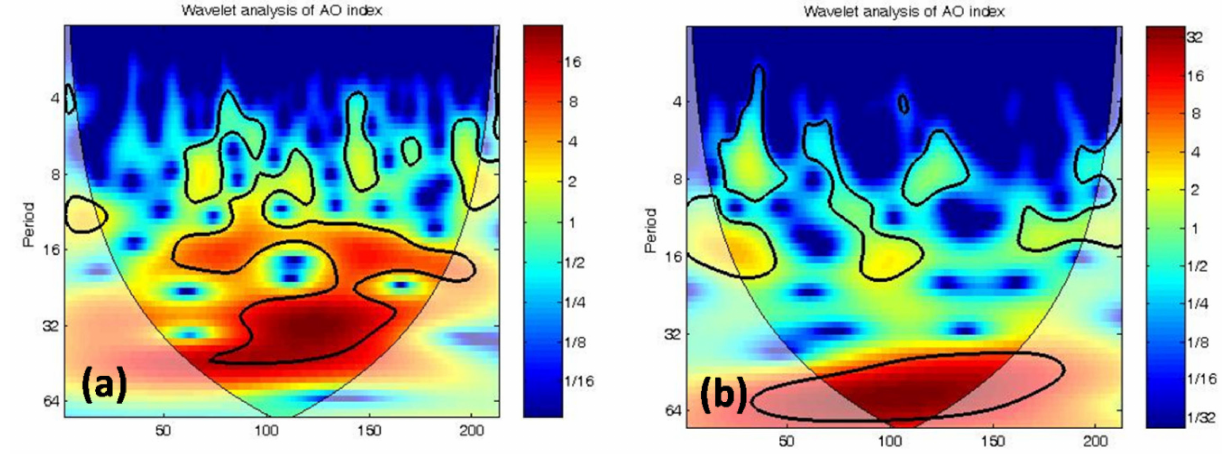
Figure 2. ( a ) The wavelet power spectrum of the AO/NAM index during the period from 1 October 2007 to 30 April 2008, using the Morlet wavelet. The left axis is the Fourier period (in days), which corresponds to the wavelet scale on the right axis. The bottom axis is time (day). The thick contour encloses regions of greater than 95% confidence for a red-noise process. The dotted-line- covered regions on either end indicate the “cone of influence”, where edge effects become important. ( b ) The wavelet power spectrum of the AO/NAM index during the period from 1 October 2009, to 30 April 2010, using the Morlet